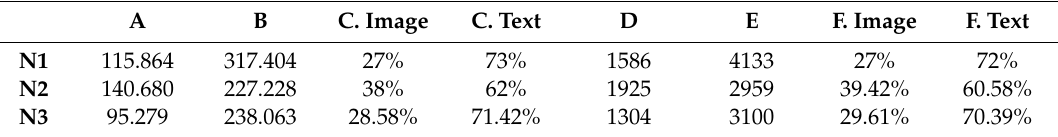
Table 7. Results of Eye-Tracker